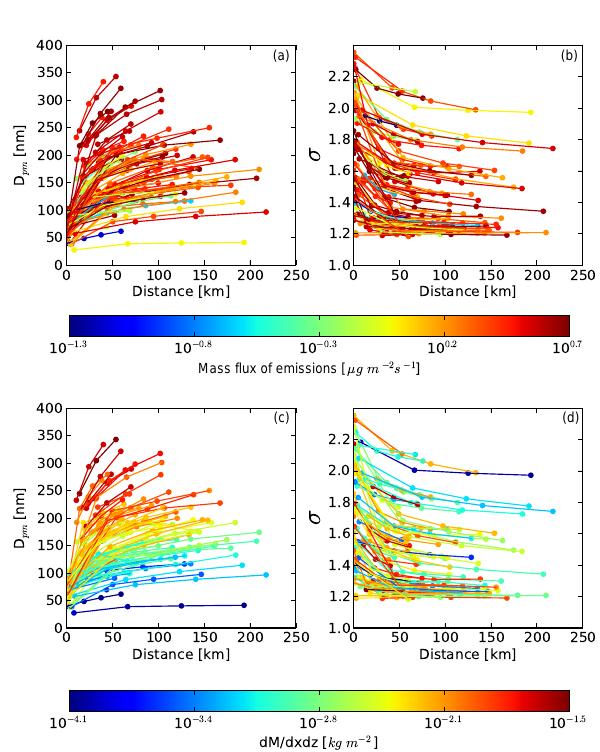
Injection height Lower plume injection bound Injection depth Depth of plume at emission